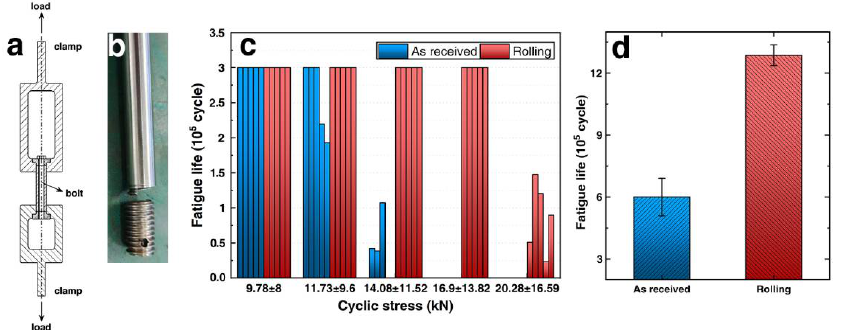
Figure 7. Average tangential and axial residual stresses (MPa), with their standard deviations measured at the surface of the thread after turning and rolling. Each measurement is marked as a point on the corresponding